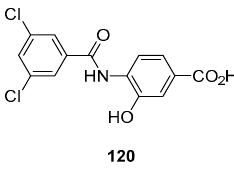
Figure 3. Structure of intermediate obtained by using Zn/acetic acid.